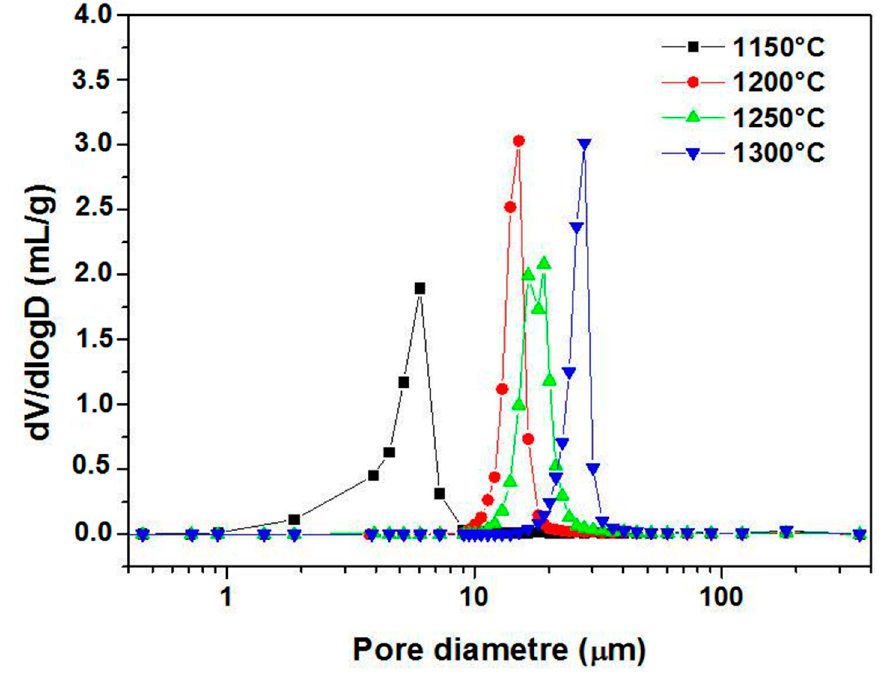
Figure 6. Pore size distribution for supports sintered at different temperatures for 1 h.